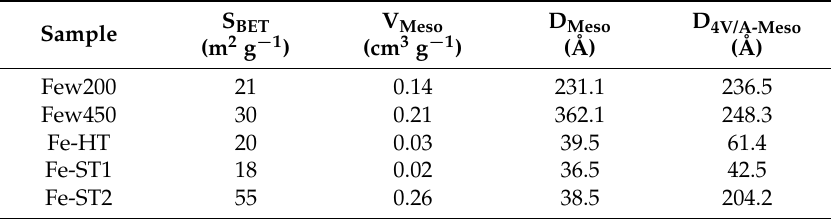
Table 2. Textural characteristics of the iron oxide catalysts